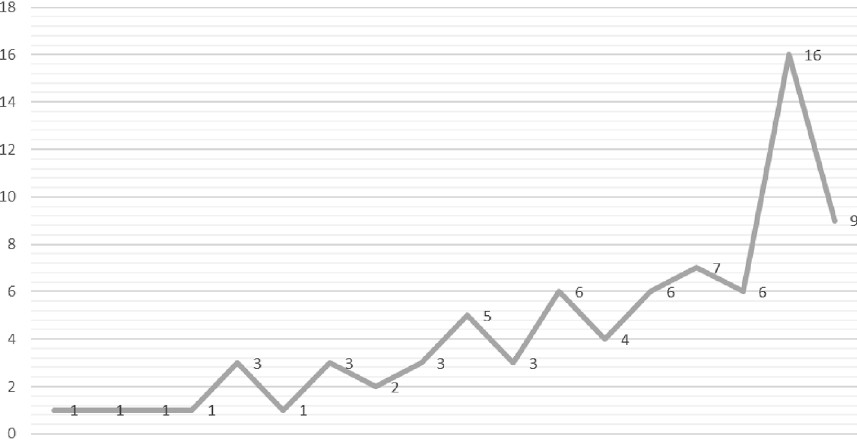
Figure 2. Evolution of scienti fi